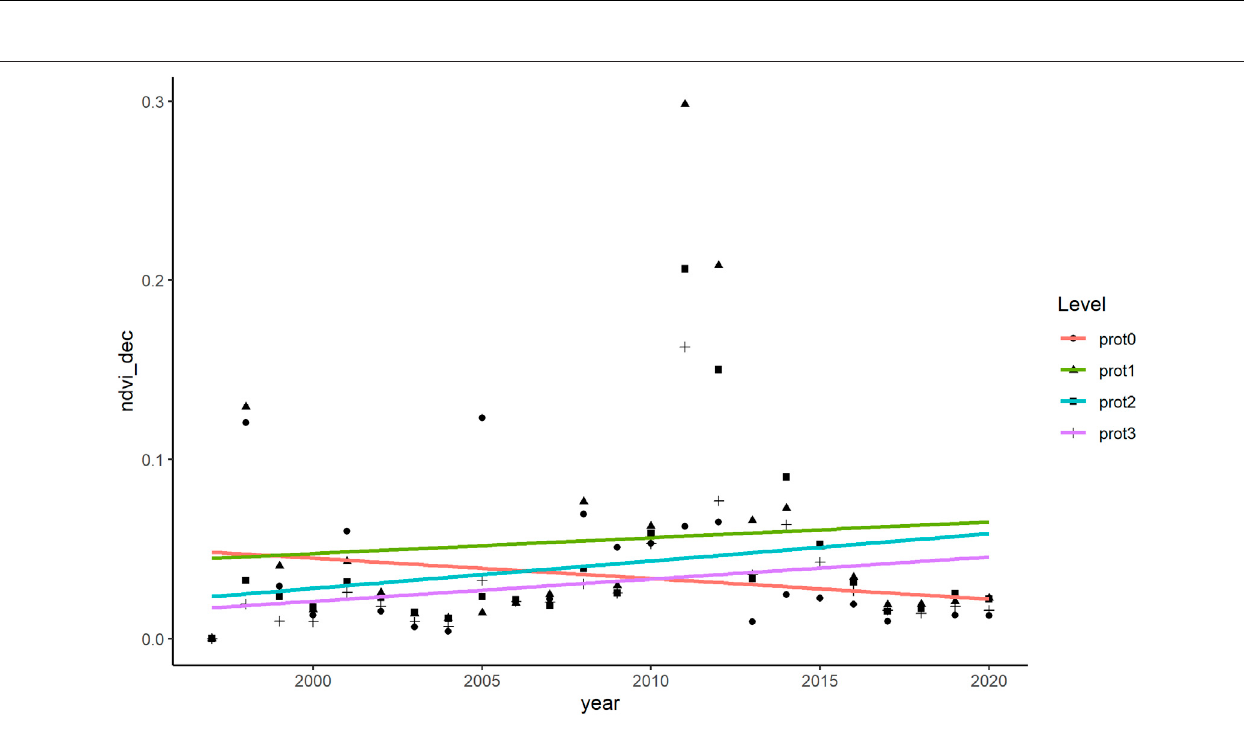
Frontiers in Remote Sensing |